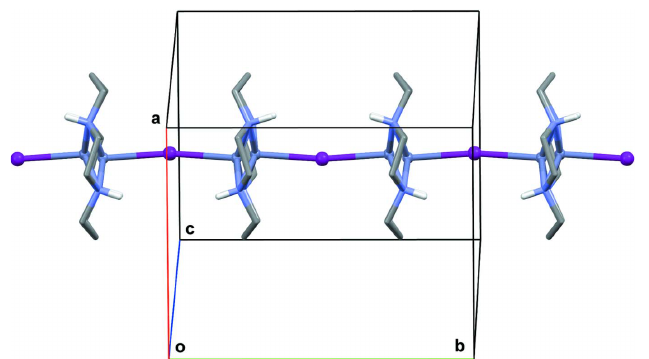
Figure 7 The packing in II viewed down the a -axis direction. C-bound H atoms are omitted for clarity.